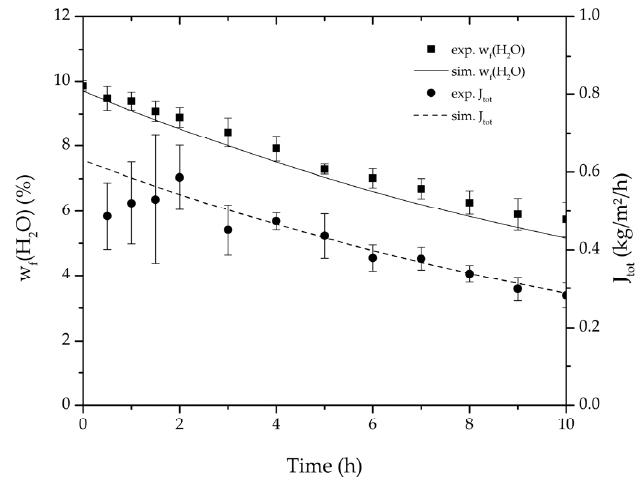
Figure 6. Average water mass fraction of the feed and total permeate flux of the thrice-repeated centre point experiments over the experimental duration for the binary system ethanol/water. The error bars represent the standard deviation, the line the simulation result.